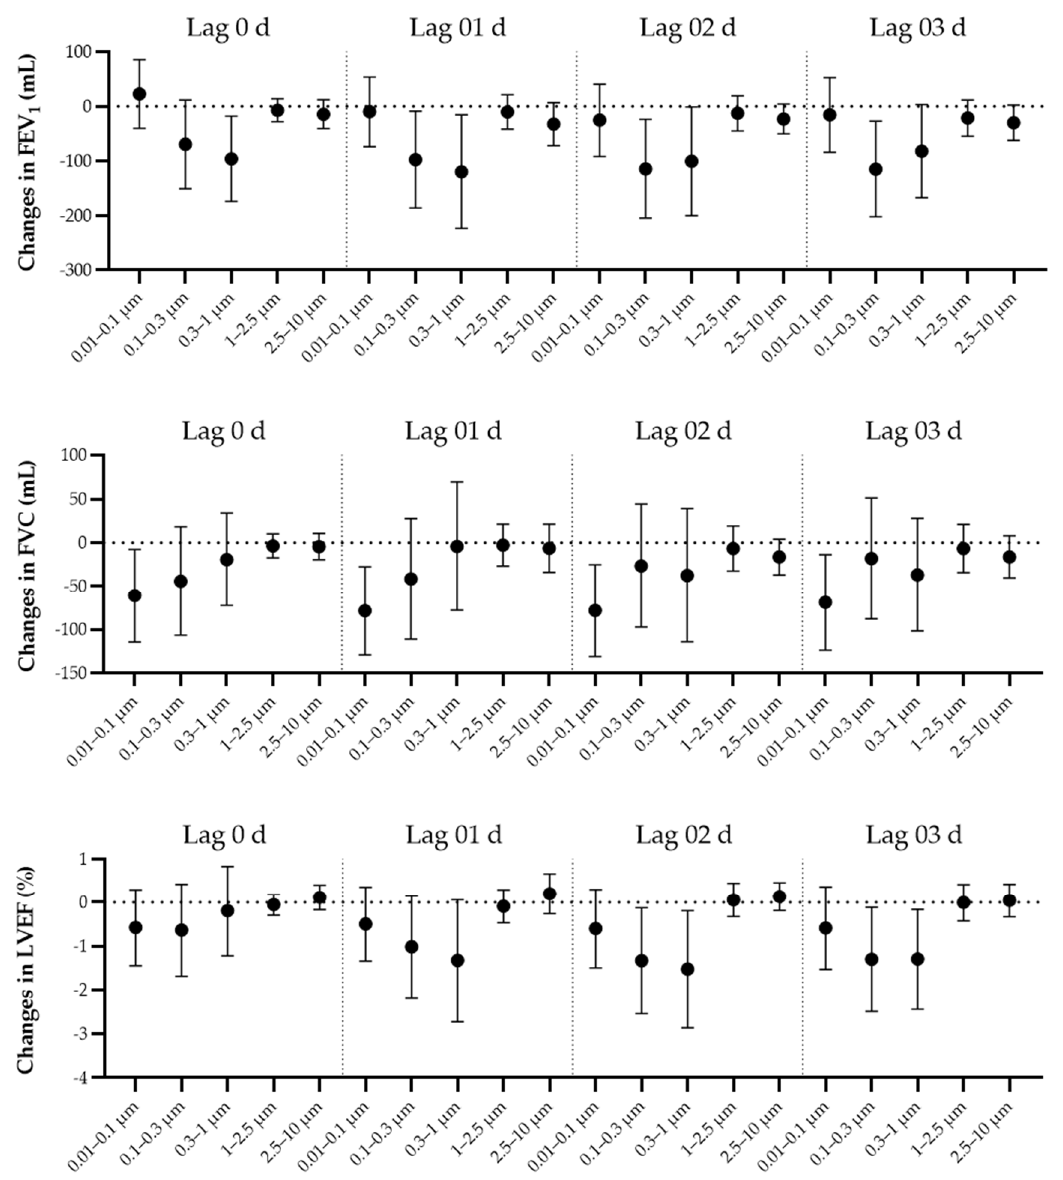
Figure 1. Changes (mean and 95% confidence intervals) in cardiopulmonary function measures associated with an interquartile range increase in size-fractioned PNC using different lag days, adjusted for PM 2.5 . Abbreviations as in Tables 1 and 2. Table 3. Changes (mean and 95% confidence intervals) in cardiopulmonary function measures associated with an interquartile range increase in size-fractioned PNC, adjusted for PM 2.5 . FEV 1 (mL) FVC (mL) LVEF